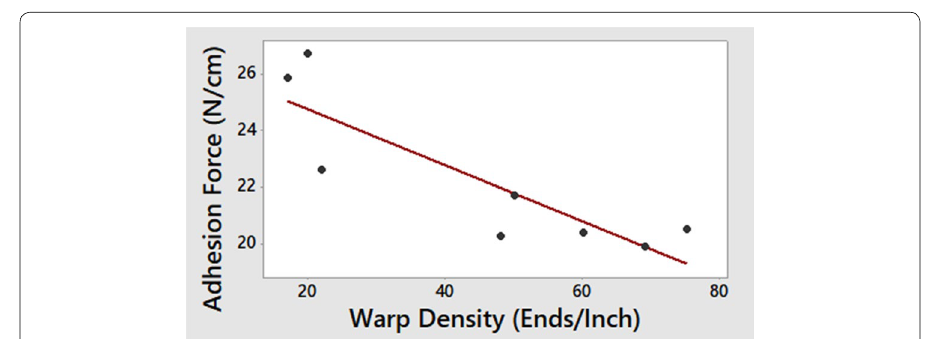
Fig. 5 Effect of ends/inch on adhesion